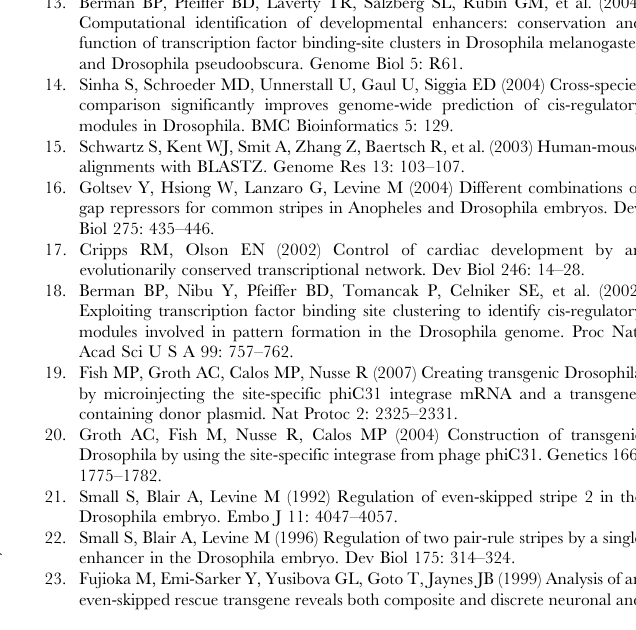
Figure S3 Enhancer prediction at the eve locus. Mean percent identity and mean percent gapped bases were calculated in 100 bp non-overlapping windows from all pairwise LAGAN alignments. Binding sites for BCD, CAD, KR, KNI, GT and HB were predicted in each fosmid using PATSER (ln (p) ,2 6). A conservation score was assigned to each site equal to the number of species in which a site for the same factor was predicted at an overlapping position in the pairwise alignment of the species. Single genome counts, conserved counts, and gapped counts of binding sites were calculated in 50 bp non-overlapping windows. Single genome counts and conserved counts of predicted binding sites in regions mapping to known D. melanogaster enhancers were predominately used for defining borders of enhancer predictions. Blue boxes show the mapped locations of D. melanogaster enhancers. Shaded grey boxes show the locations of tested enhancers. Figure S4 Fine-scale sequence and binding site heterogeneity for stripe 3 + 7, stripe 4 + 6 and the MHE. Predicted binding sites for factors known to regulate expression from the (A) eve stripe 3 + 7, (B) stripe 4 + 6 and (C) muscle heart enhancers in six Drosophila species [56] and six sepsid species. Sites were predicted independently in each species using PATSER [61] and mapped onto an MLAGAN [65] multiple alignment of the eve enhancer sequences. The height of the box representing each binding site is scaled by its PATSER p-value (taller boxes represent sites with higher predicted affinities). The top panel (grey shading) shows the positions of biochemically-verified (in vitro footprinting) binding sites [27]. The indicated coordinates are for the multiple-alignment, which is longer than individual enhancers due to the high frequency of alignment gaps.